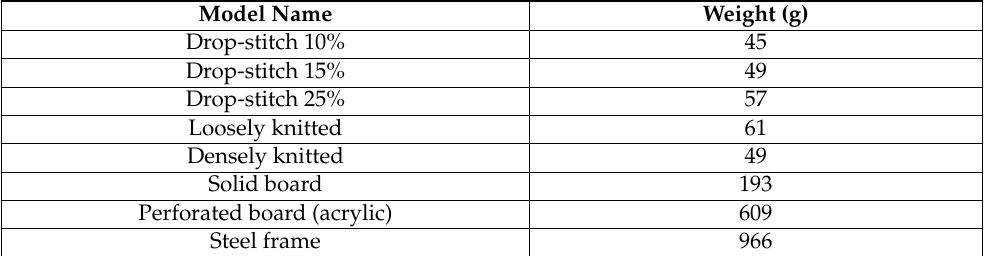
Table 2. Weight of the